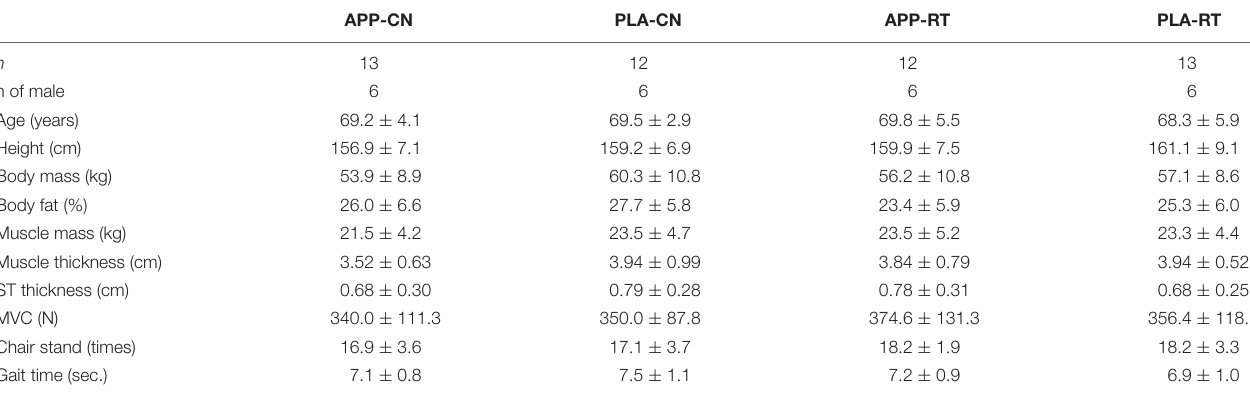
TABLE 1 | Characteristics of the